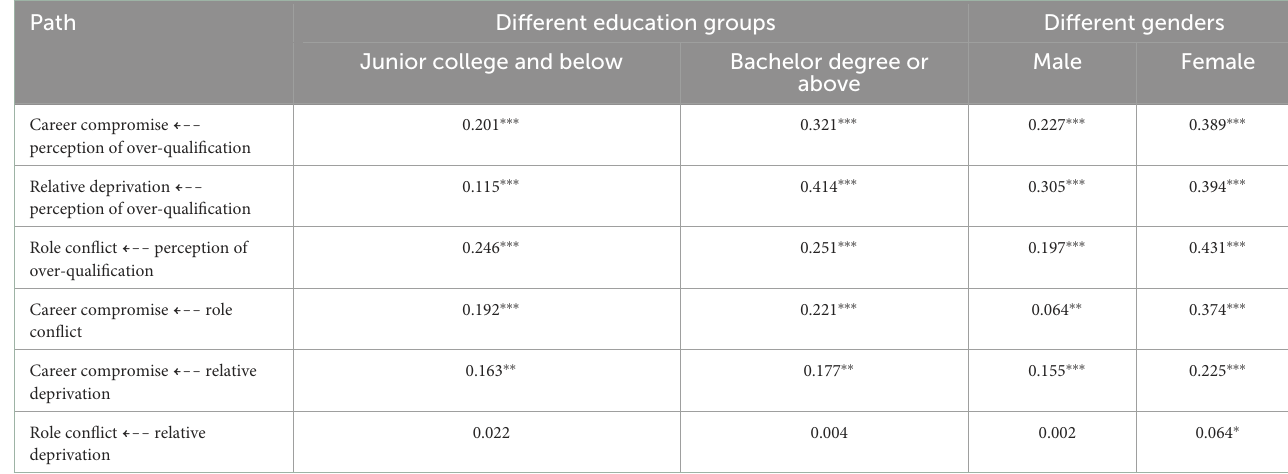
TABLE 8 Comparison of path standardization coefficient between different groups.